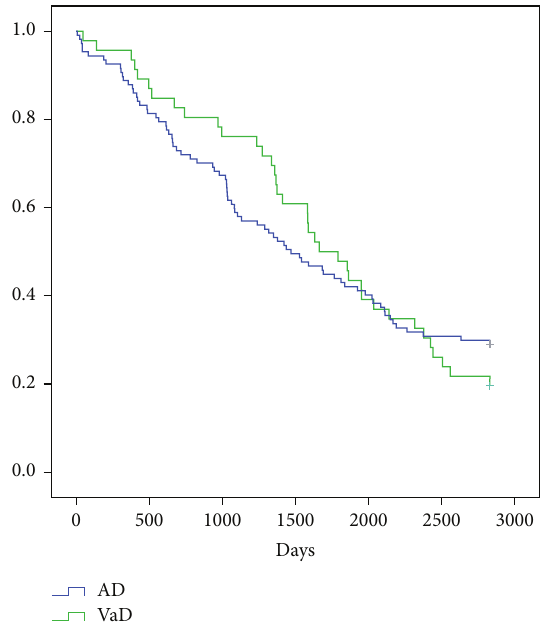
Figure 1: Survival curves of the two patient groups. AD: Alzheimer’s disease; VaD: vascular dementia. No significant difference ( 𝑃 = 0.873 ) between the mortality rates of the two groups.